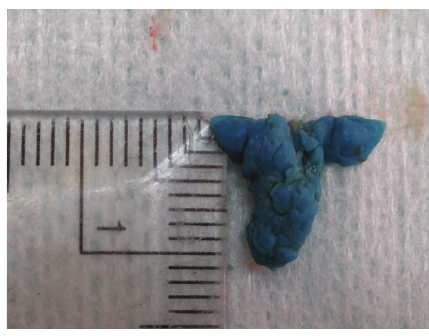
Figure 6: Measurements of the excised mass revealed dimensions of 10 × 7.5 mm.